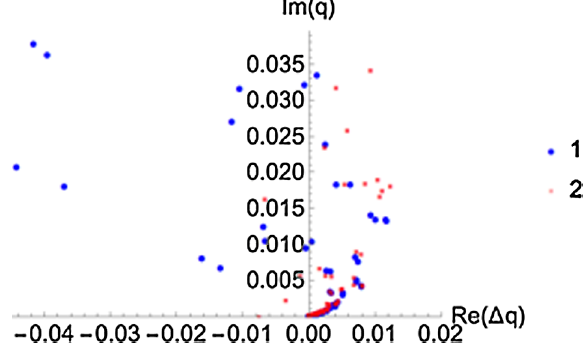
FIG. 33. Tune shifts of unstable modes for the APS single bunch broadband impedance model at chromaticity ξ ¼ 10 , ImpF ¼ 2 , damper off (blue, 1), and with resistive gain g ¼ 1 . 4 (red,